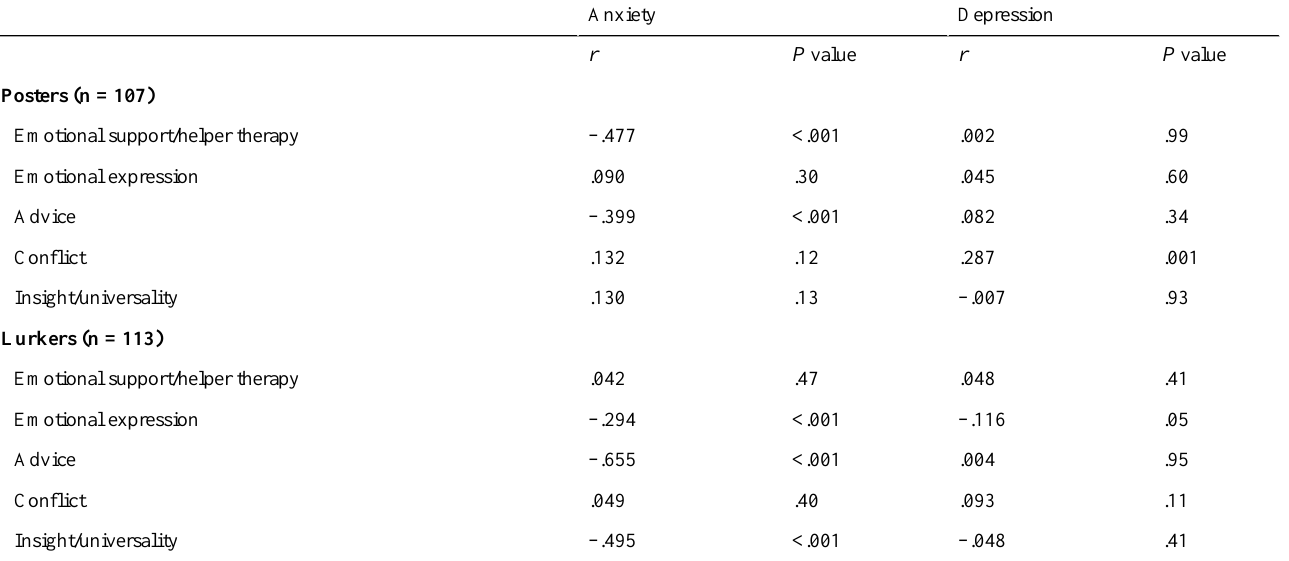
Table 5. Correlations between support score and mental health as measured by the Hospital Anxiety and Depression Scale (HADS) subscales anxiety and depression (n = 220) (excluding missing